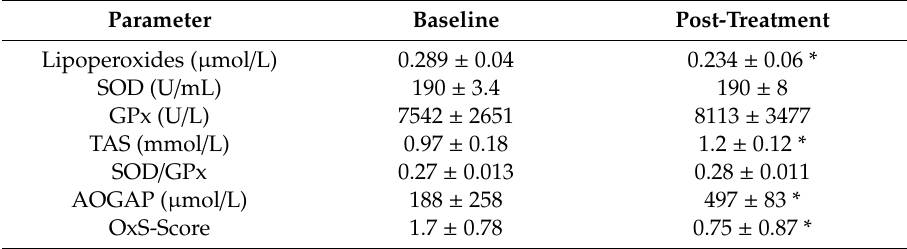
Table 3. Markers of oxidative stress before and after treatment.